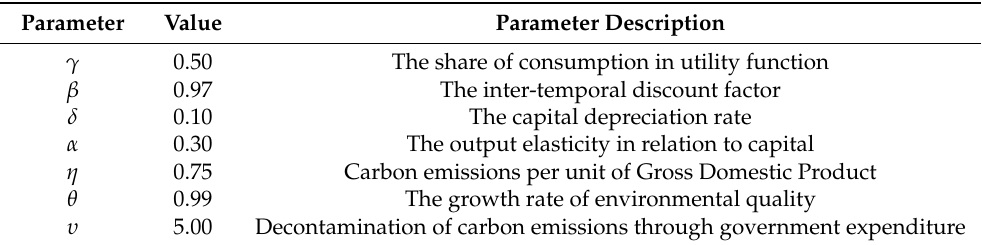
Table 1. Calibrated parameters obtained from the previous literature. Parameter